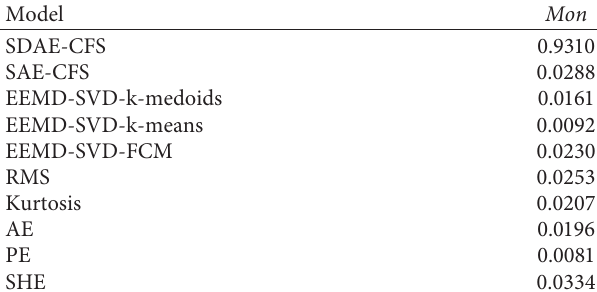
Figure 29: CVs for bearings 11–15 by using AE. (a) Bearing 11. (b) Bearing 12. (c) Bearing 13. (d) Bearing 14. (e) Bearing 15. Table 2: Mon result of different models by using bearing 12